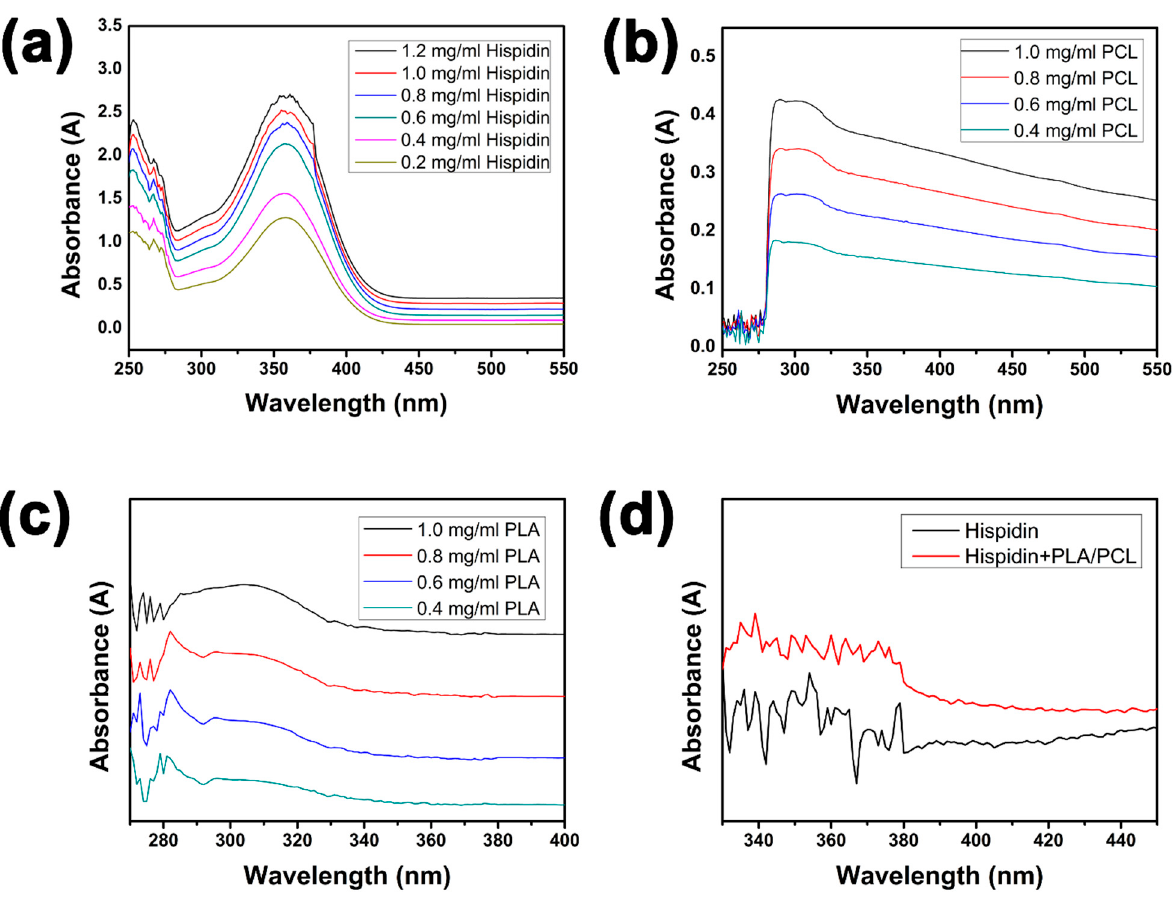
Figure 2. In vitro skin permeability of hispidin with PLA/PCL blended MNs. ( a ) Ultraviolet-Visible (UV–Vis) spectroscopy of hispidin, ( b ) PCL, ( c ) PLA, and ( d ) MN in vitro tested sample.